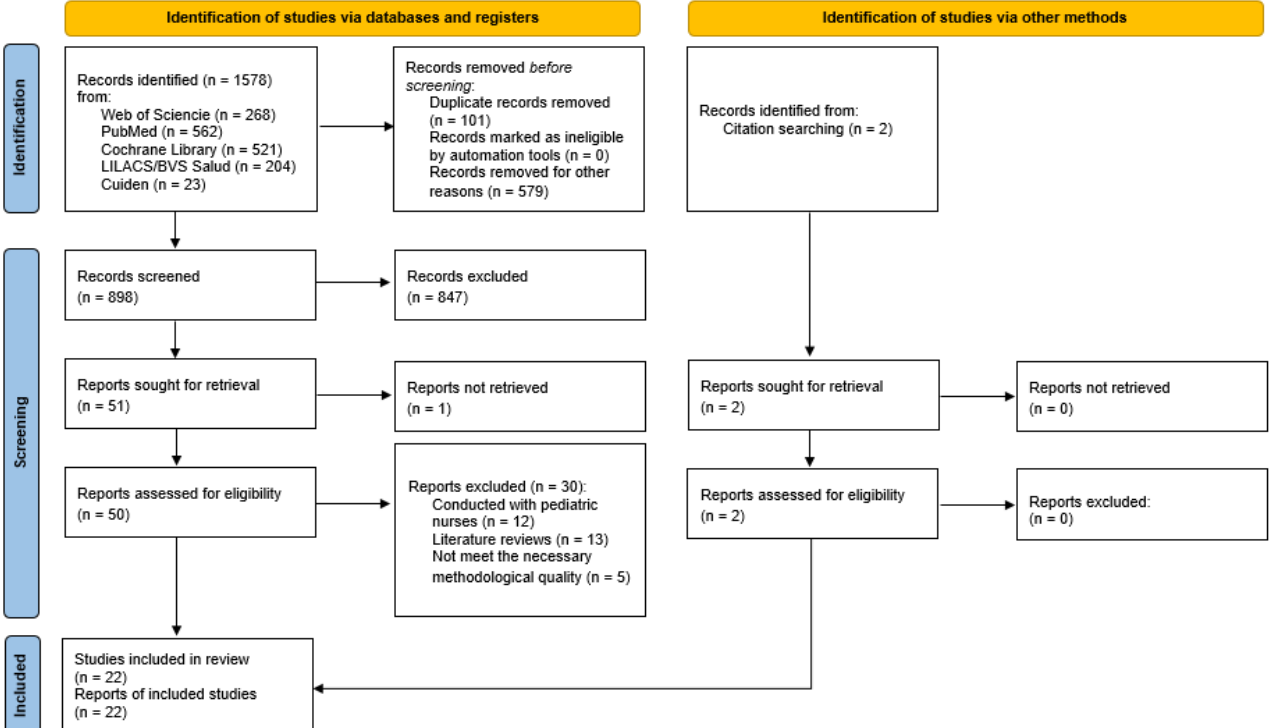
Figure 1. Flow chart.